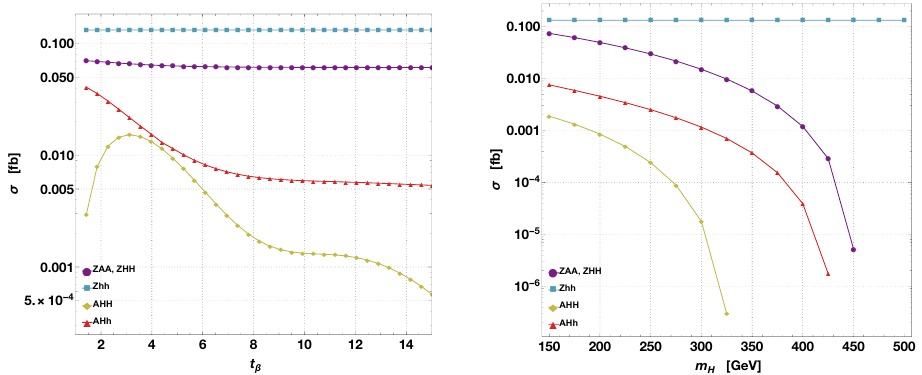
Figure 6 . The distributions of the cross sections for all the processes as a function of t (cid:12) (left) and p m H (right) at s = 1 TeV. The mass of the extra Higgs states is set to m H = 175 GeV (left) and t (cid:12) = 10 (right),